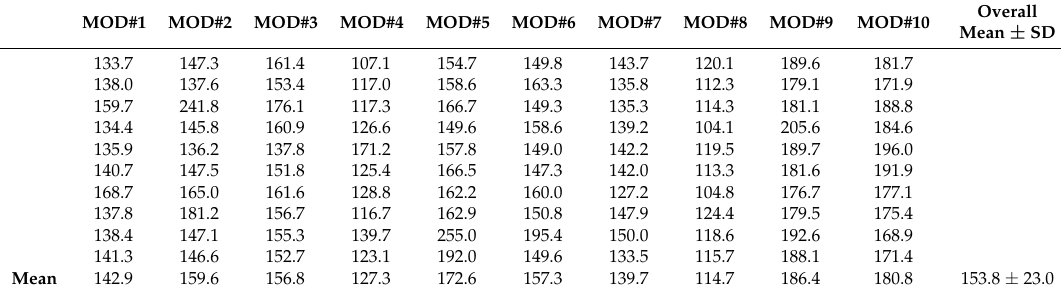
Table A1. Trueness of full-arch scan performed on each maxillary typodont with an intraoral scanner (Trios 3, 3Shape, Copenhagen, Denmark) expressed in terms of the root mean square (RMS) values ( µ m). MOD, model. SD, standard